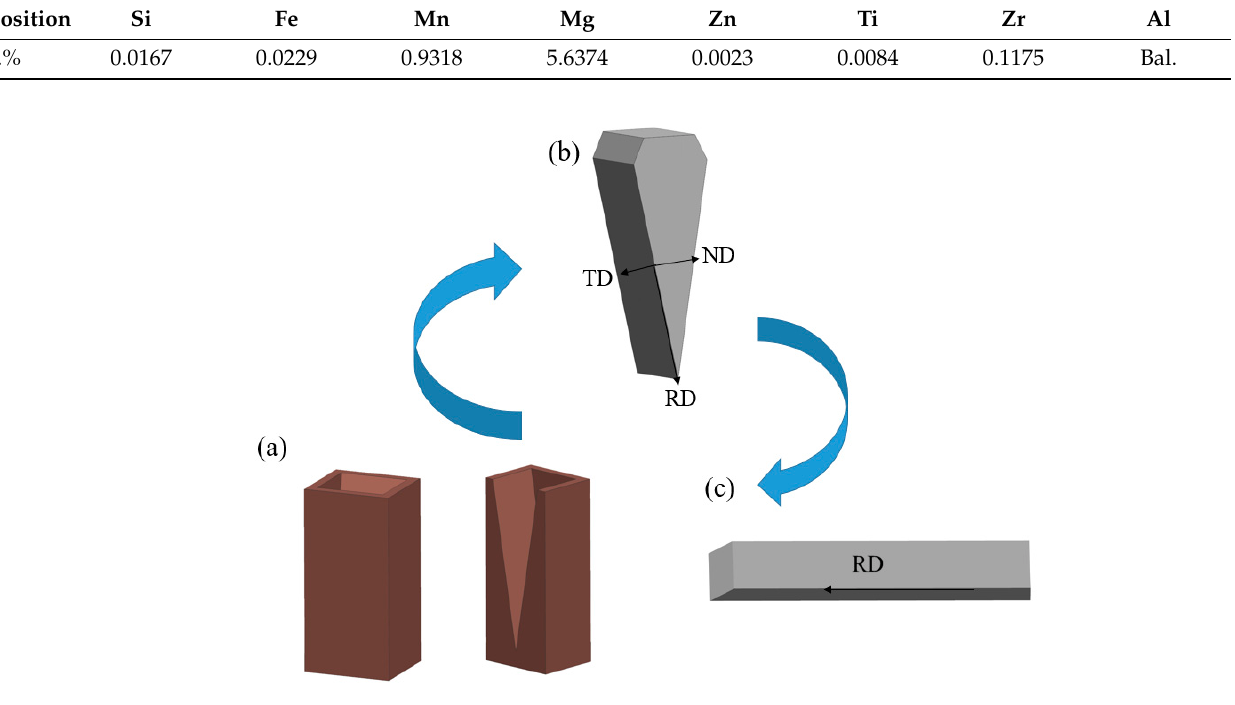
Figure 1. The wedge copper mold casting experimental equipment and obtained materials ( a ) Wedge-shaped copper mold; ( b ) 1561 aluminum alloy ingot; ( c ) 1561 aluminum alloy hot rolled